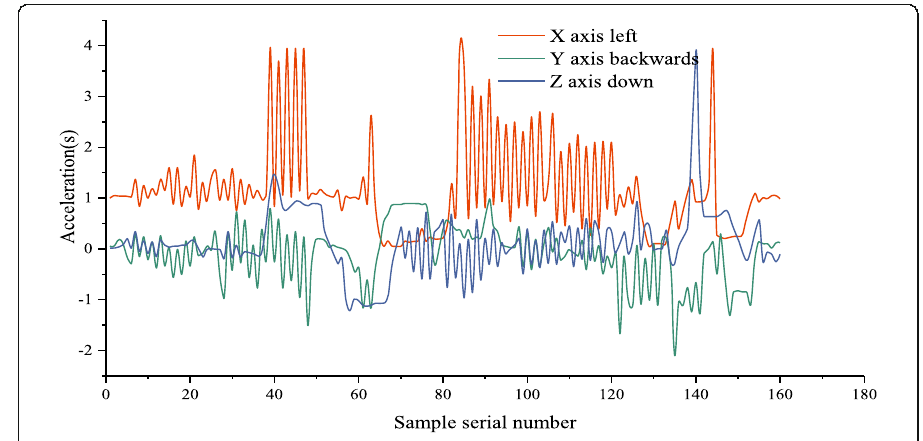
Fig. 4 Human body fitness status information based on Internet of Things monitoring